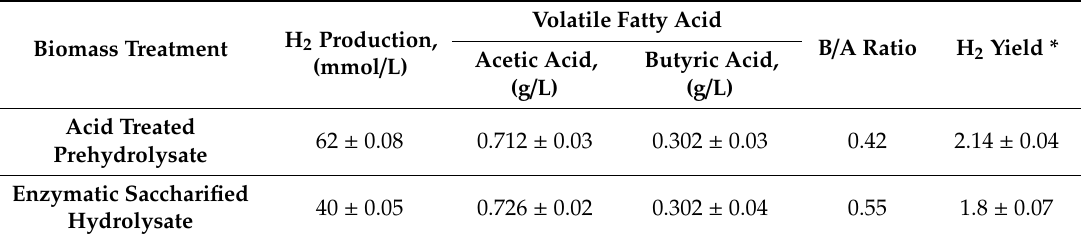
Table 5. Soluble metabolites production during hydrogen production by E. cloacae DT-1 under decreased partial pressure. Hydrogen productivity and yield e ffi ciency details indicated in